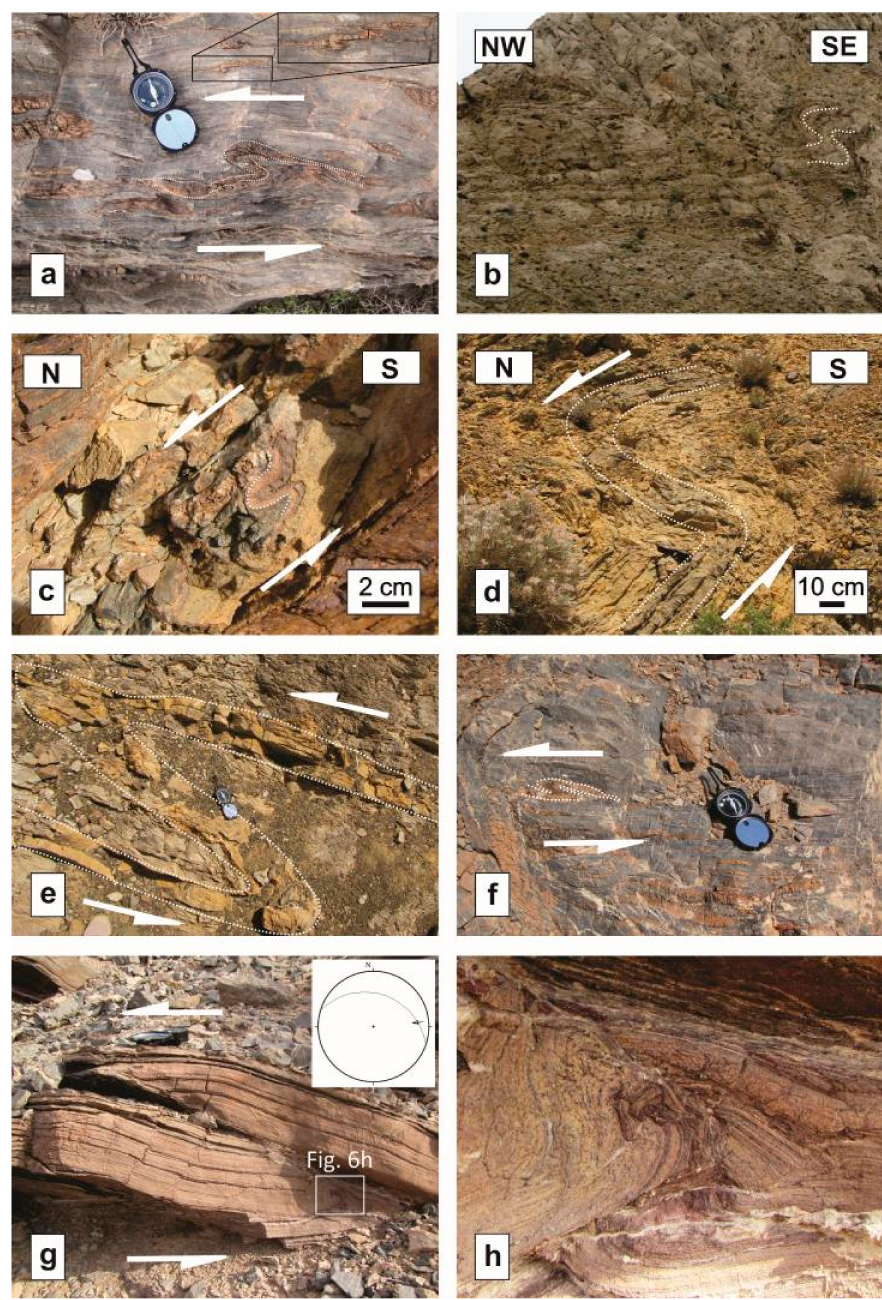
Figure 6. ( a ) A sinistral ptygmatic fold in a chert layer in the metamorphosed Permian limestones of the Abdolmomen 2 shear zone; ( b ) An asymmetric fold highlighted by brown chert layers which suggest sinistral top-to-the NW sense of shear; ( c ) An outcrop-scale asymmetrical fold in the dolomitic limestone layers; ( d ) A mesoscopic sinistral asymmetric fold in the Middle Triassic thickly-bedded dark brown dolomite; ( e ) A mesoscopic sinistral top-to-the NW asymmetric fold in the Lower Triassic marl and limestone unit of the Sourmagh shear zone; ( f ) A sinistral ptygmatic fold in a chert layer in the metamorphosed Permian limestones of the Abadeh shear zone; ( g ) A mesoscopic top-to-the W thrust in the well-bedded limestones and dolomites. The inset presents stereographic projection from the lower hemisphere showing the orientation of the foliation, stretching lineation, and the sense of shear; ( h ) A mesoscopic thrust-related asymmetric fold that suggests a top-to-the W sense of shear. The open compasses without fold-out pointers are 15 cm long and the fold-out pointers are toward N ( a , e , f , g